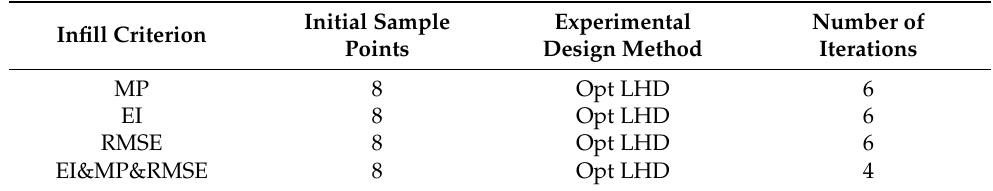
Table 3. 2 − D function (Branin) related validation data.